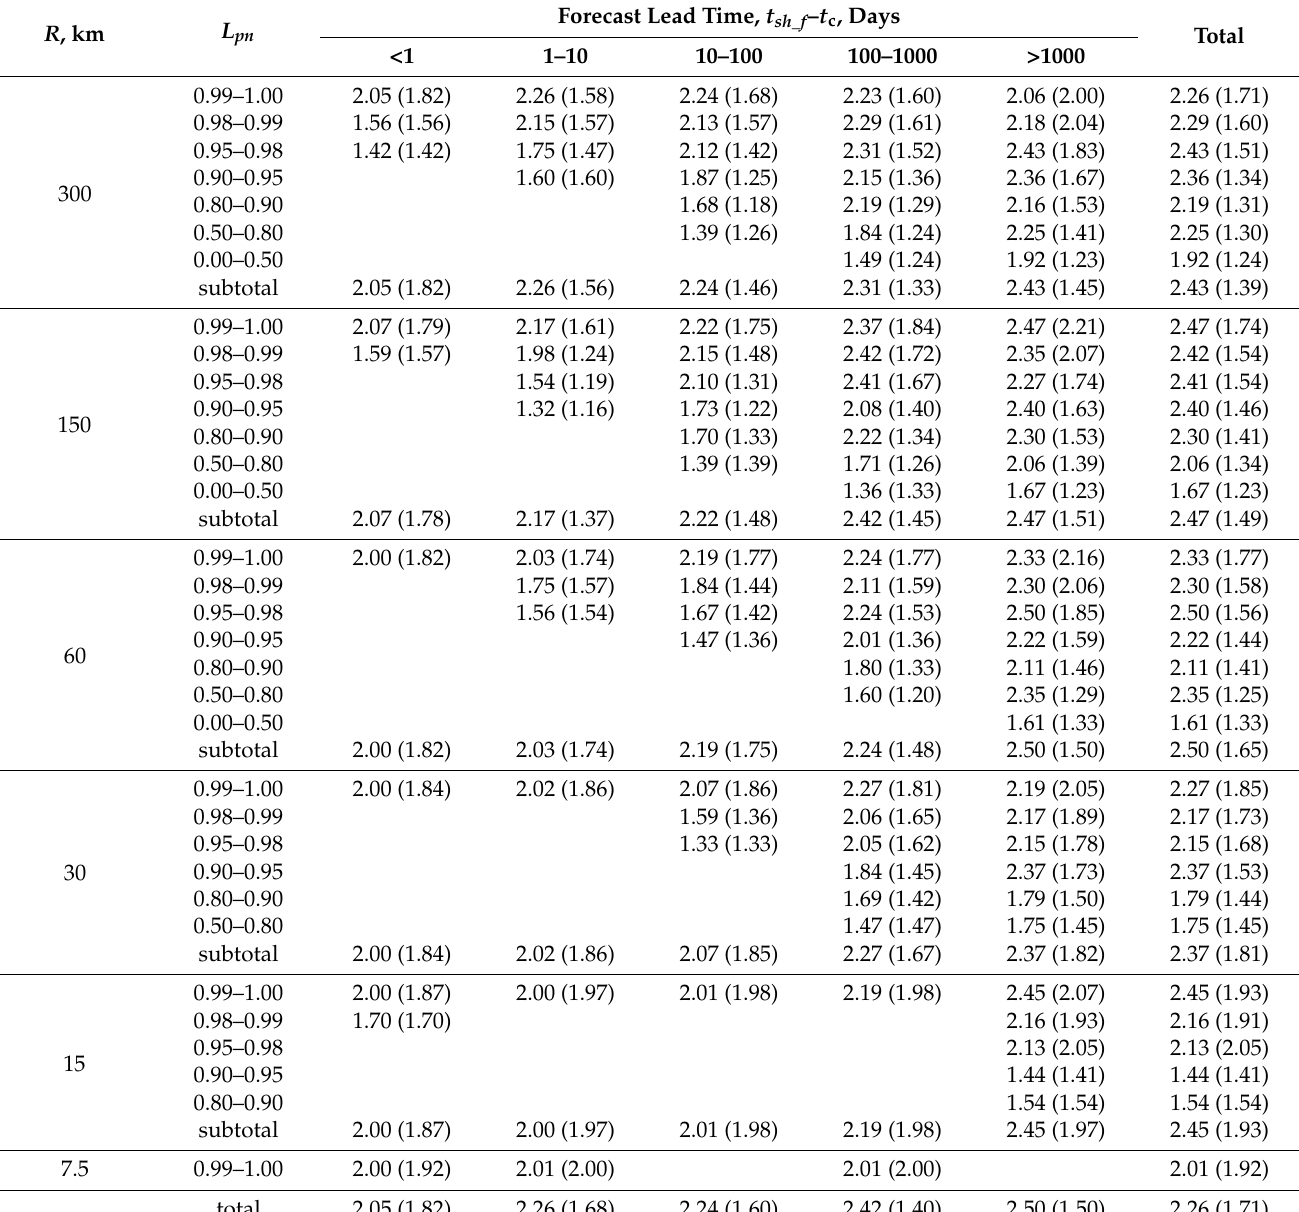
Table A4. The maximum (average) approximation–extrapolation relation A of foreshock retro- forecasts depending on the sample radius R , predictive nonlinearity L pn and forecast lead